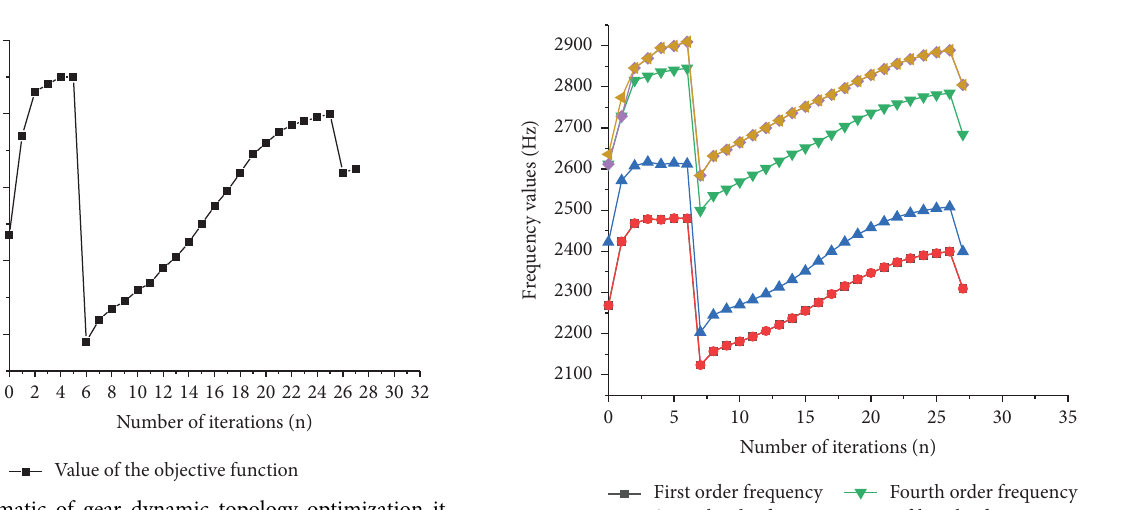
Figure 8: Schematic of gear dynamic topology optimization it- eration process.